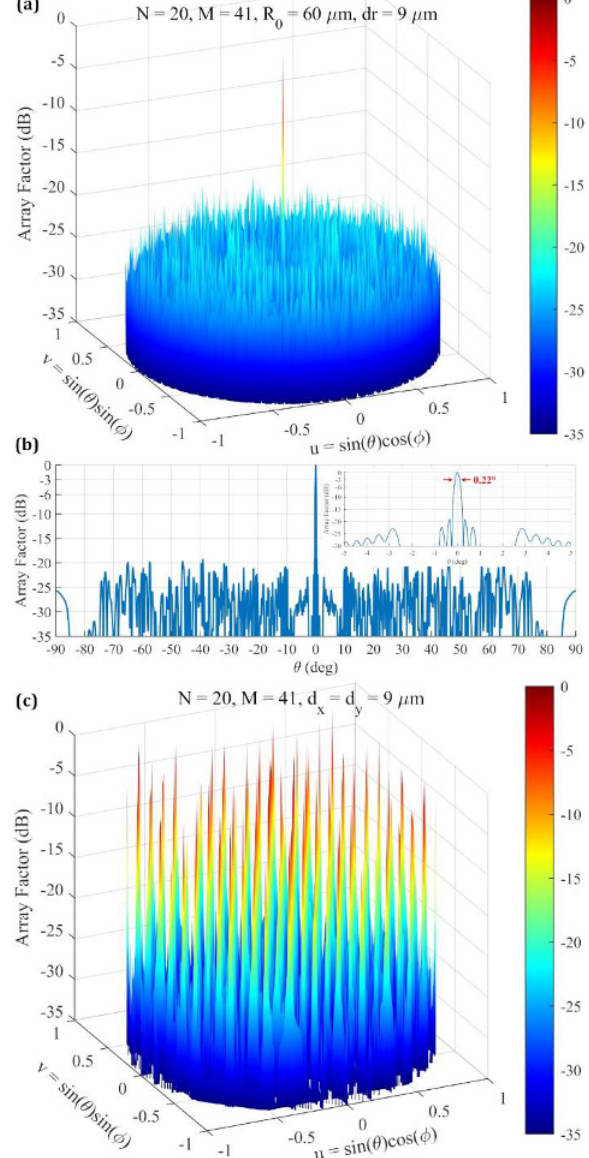
Fig. 2. (a) Simulated amplitude of the array factor in dB in uv space for Array with N = 20, M = 41, 𝑅 0 = 60 µm, 𝑑𝑟 = 9 µm at θ = 0°, ϕ = 0°; (b) Elevation cut ( ϕ = 0° ) of the array factor of Array 1; inset in (b) shows the zoom-in view of the array factor when elevation angles are in the range of - 5° < θ < 5° ; (c) Simulated array factor in dB of rectangular array with N = 20, M = 41, 𝑑 𝑥 = 𝑑 𝑦 = 9